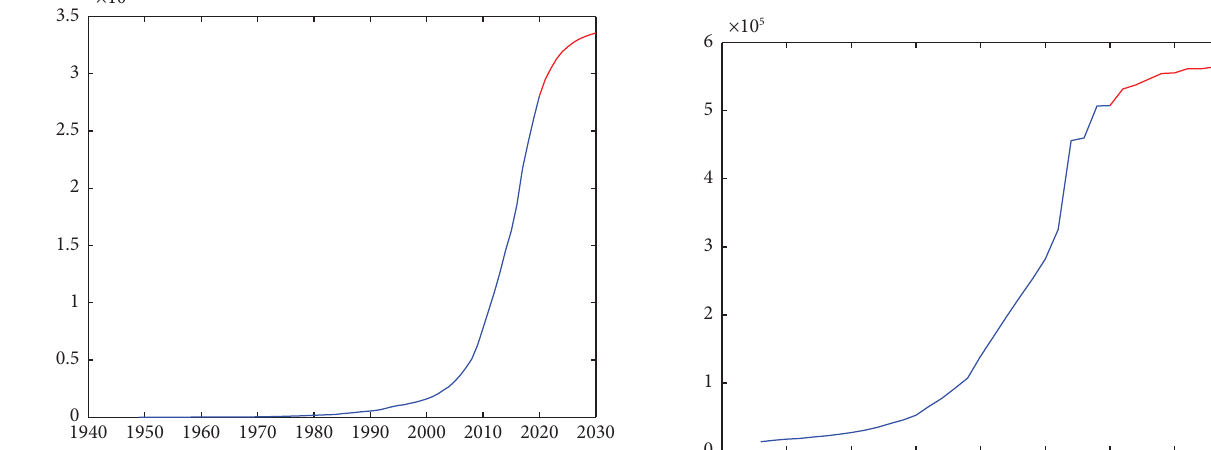
Figure 4: Forecast of vehicle ownership quantity in China.